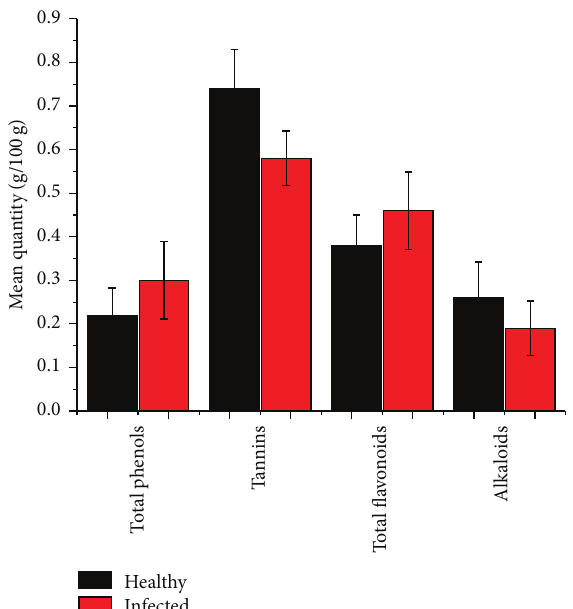
Figure 2: Quantification of secondary metabolites (g/100g) in healthy and infected stem bark of mango suffering from quick decline disease. Each Bar represents mean ± SD contents of the specific secondary metabolite as indicated.